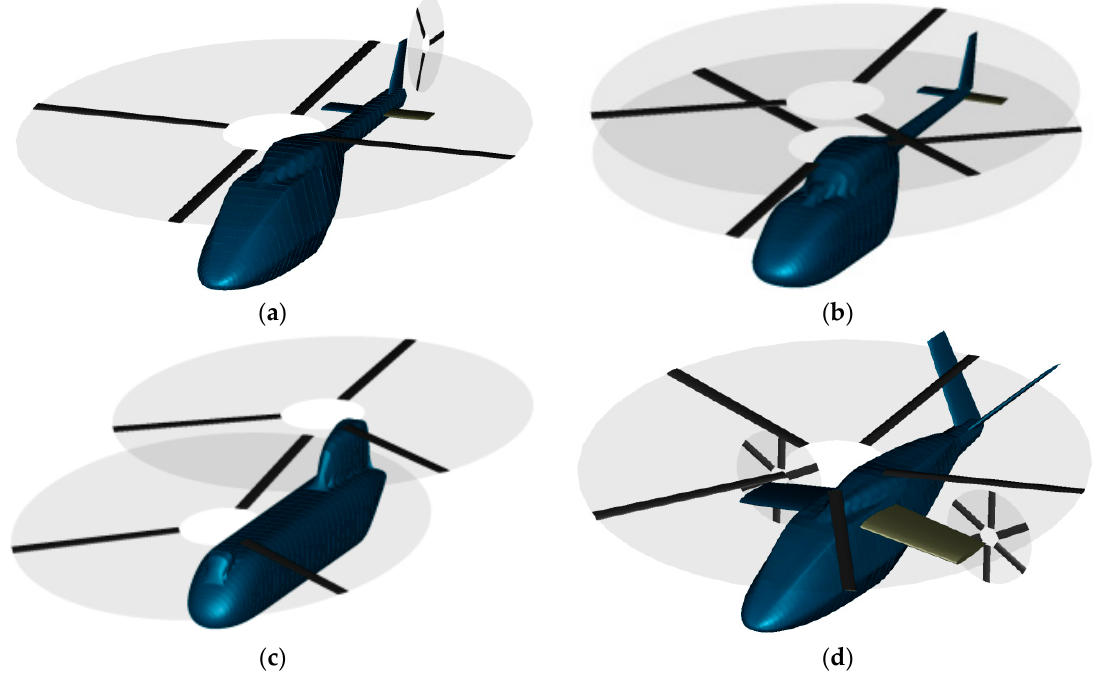
Figure 6. Four examples for external configurations: ( a ) the standard configuration with one main rotor and a lengthened front for retractable landing gear and a higher amount of avionics; ( b ) the coaxial configuration with a fuselage loft for the installation of landing skids; ( c ) the tandem configuration with long cabin part and tail cap; ( d ) compound configuration including wings, propellers, a V-tail and a long rear part.